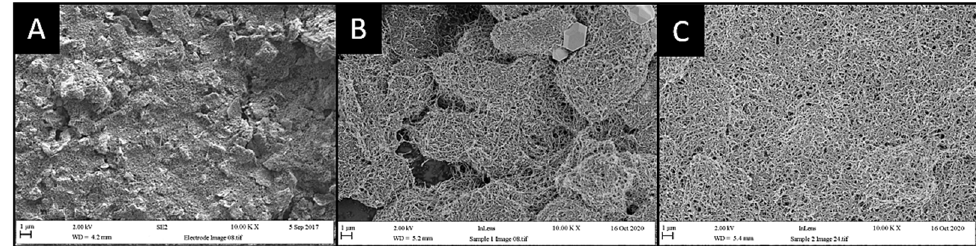
Figure 3. SEM micrographs of MWCNTs in sonicated solutions of ( A ) dH 2 O, ( B ) enzymatic solution, and ( C ) MES buffer solution. Typical heterogeneous surfaces are demonstrated by carbon SPEs ( A ) contributing to MWCNT aggregate formation ( B ). Under enzymatic interaction, MWCNTs demonstrate more homogeneous dispersion with the electrode surface ( C ).